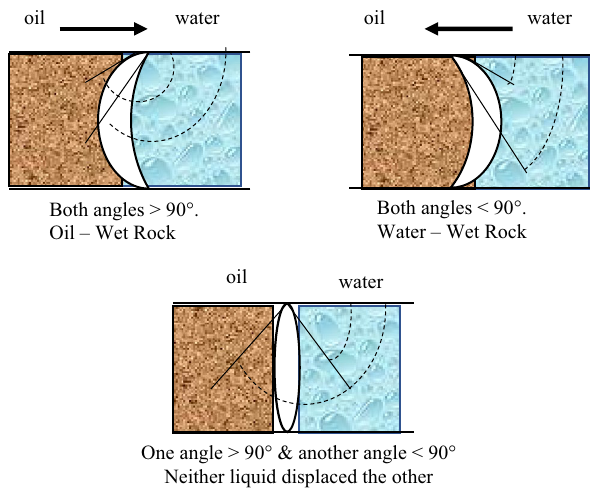
Fig. 1 Schematic of three scenarios of hysteresis phenomenon in wet- tability (Benner et al.